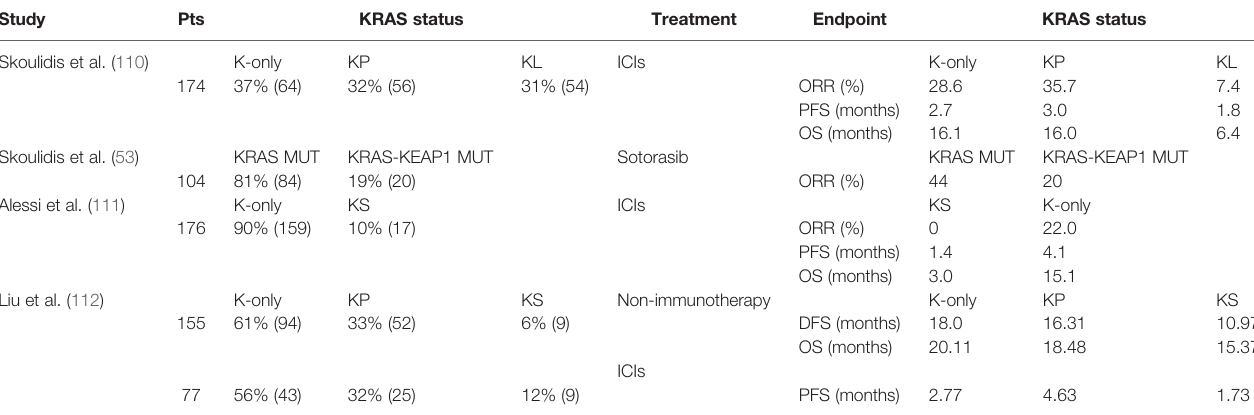
KRAS, kirsten rat sarcoma viral oncogene homolog; Pts, patients; KL, KRAS-STK11/LKB1 co-mutant; KP, KRAS-TP53 co-mutant; ORR, objective response rate; PFS, progression-free survival; OS, overall survival; MUT, mutation; KEAP1, Kelch-like ECH-associated protein 1; ICIs, immune checkpoint inhibitors; KS, KRAS-SMARCA4 co-mutant; DFS, disease-free